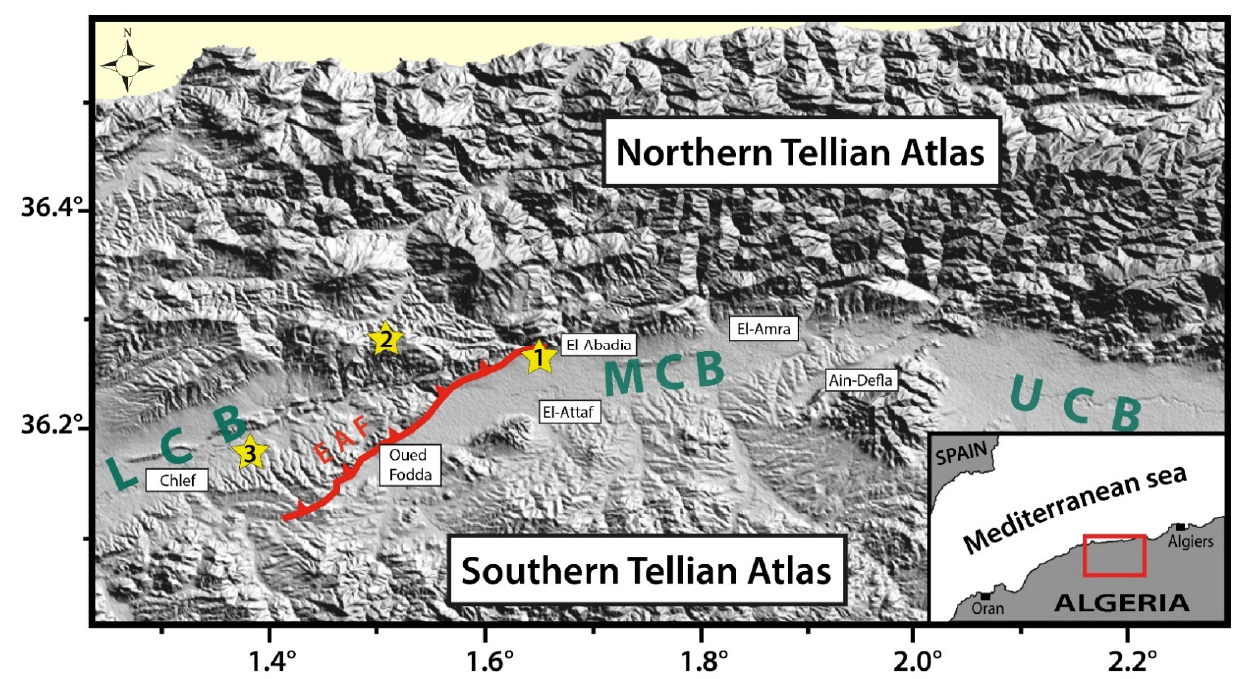
Figure 1. Location of the study area. The numbered yellow stars correspond to the epicenters of the major earthquakes in the area: (1) the 1934 Carnot (I 0 = IX) earthquake, (2) the 1954 Orléansville ( Ms 6.7) earthquake, and (3) the 1980 El ‐ Asnam earthquake (Mw 7.2). EAF = El ‐ Asnam fault trace; UCB = Upper ‐ Chelif Basin; MCB = Middle ‐ Chelif Basin; LCB = Lower ‐ Chelif Basin